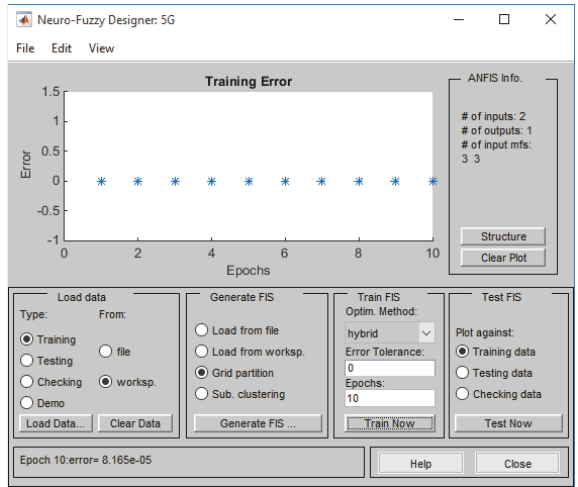
Figure 12: Training error. It equals 0 meaning the training was